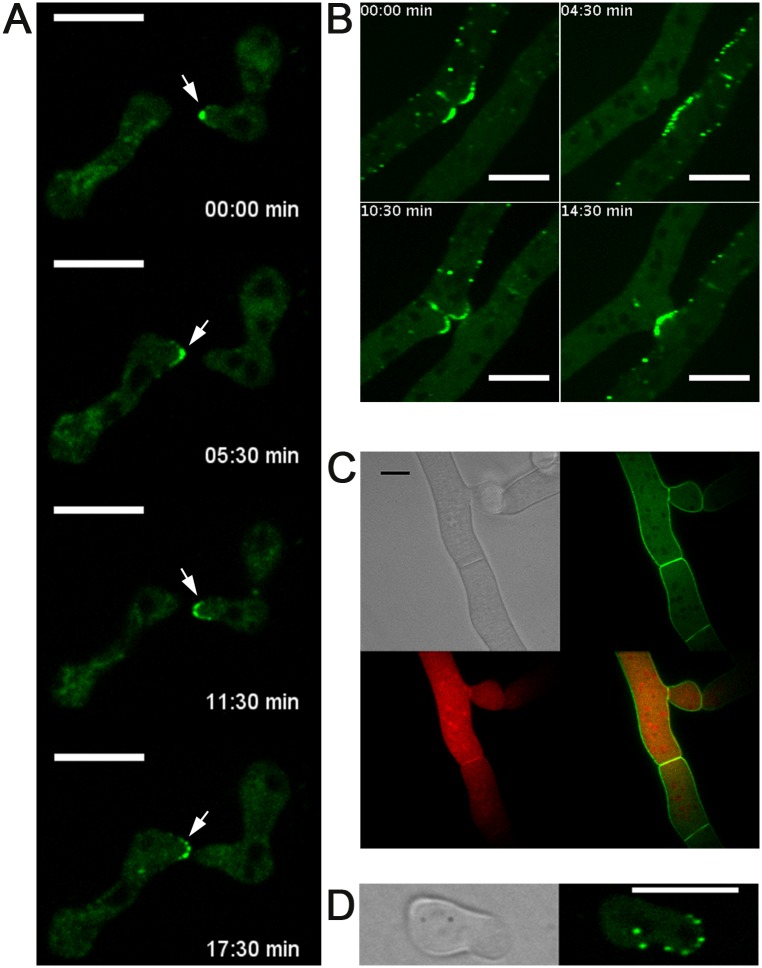
Cellular localization of DOC-1-GFP and DOC-2-GFP.(A) DOC-1-GFP showed dynamic localization to puncta at the tips of conidial anastomosis tubes during chemotropic interactions between genetically identical cells, with an oscillation period of 8–10 min within a single germling tip. See S5B Fig for oscillation intervals and S3 Movie for interacting germlings. (B) Oscillation of DOC-1-GFP in hyphae in a single colony undergoing chemotropic interactions prior to cell fusion. See Fig 5A for oscillation intervals and S4 Movie for interacting fusion hyphae. (C) DOC-2-GFP (green, top right panel) localized to the plasma membrane in mature hyphae. Co-localization between DOC-2-GFP with MAK-2-mCherry (red, bottom left panel) was not observed (overlay, bottom right panel). (D) tef-1 driven GFP-DOC-2 (green) showed localization to puncta in germlings, but that do not show oscillation during chemotropic interactions. Scale bars: 10 μm.